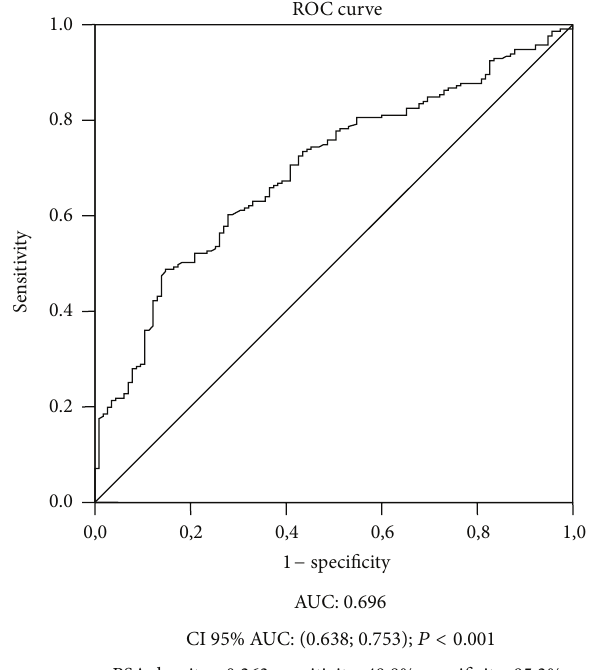
Figure 3: Receiver Operating Characteristic curve analysis for PSA density to preoperatively predict Gleason